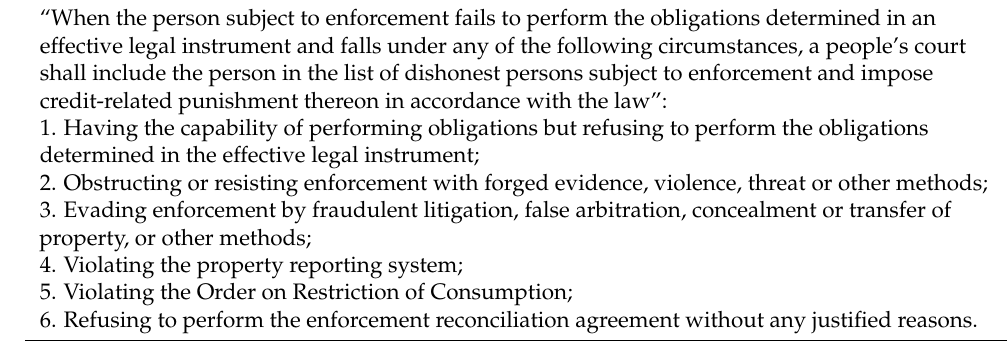
Table A2. Definition of “dishonest persons subject to enforcement” from the court (The Supreme People’s Court of The People’s Republic of China